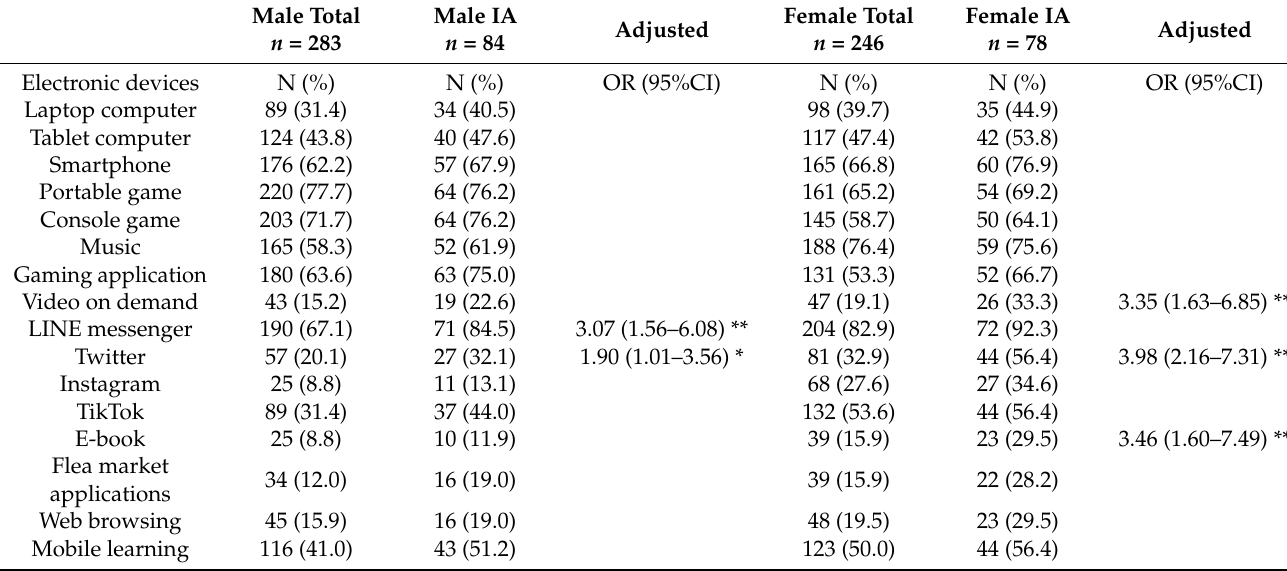
Table 3. Multiple logistic regression analysis of effect of electronic devices and applications on internet